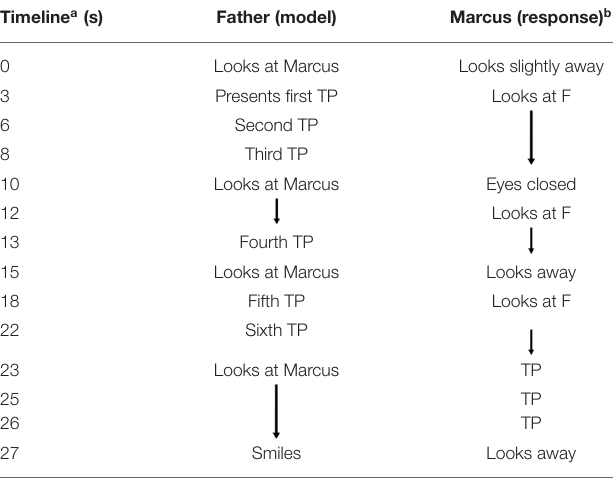
TABLE 3 | A sequential overview of the home video showing Marcus responding with tongue protrusion (TP) to his fathers’ modeling. Timeline a